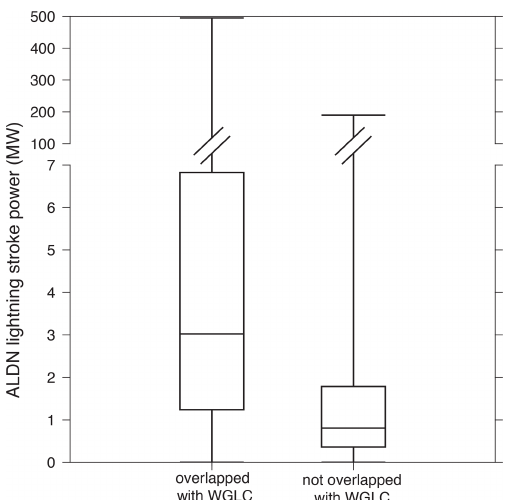
Figure 13. Lightning stroke power where strokes were present in both ALDN and WGLC datasets compared to those that were only present in the ALDN data. Lightning stokes present in both datasets tend to have greater power. Lightning strokes “missing” from the WGLC tend to be the weaker lightning